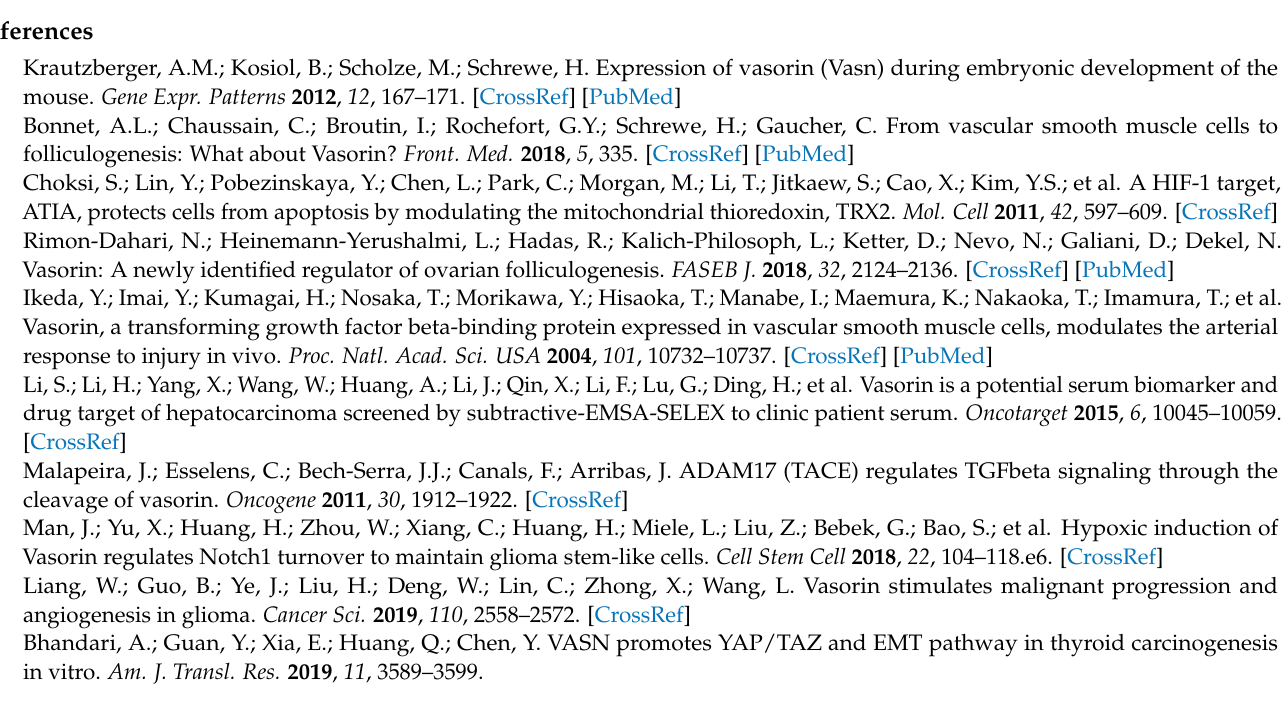
mice. Table S3: Bioinformatics predicted the targets of DE-miRNAs. Table S4: Pathway enrichment analysis of DE-miRNA targets between wild-type and Vasn − / − mice. Table S5: KEGG enrichment results revealed DE-miRNA targets and related pathways between wild-type and Vasn − / −